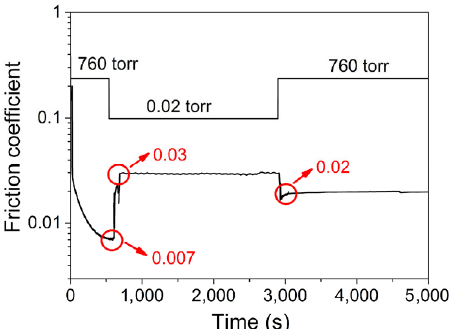
Fig. 4 Effect of the hydrogen bond strength in hydrated water layer on water-based superlubricity behavior in vacuum. The friction coefficient is measured under the lubrication of mixture of glycerol and H 3 PO 4 solutions, and the other experimental parameters are the same as those in Fig.